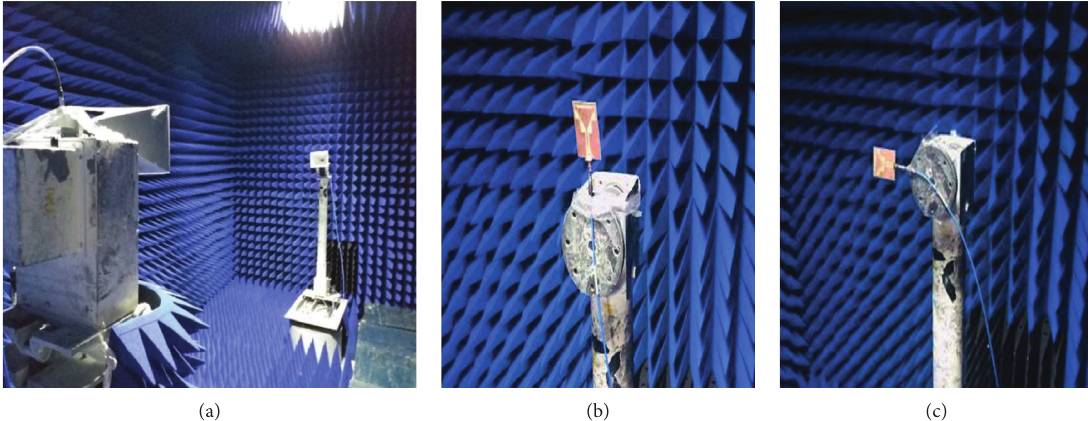
Figure 6: Photograph of tested antenna inside the chamber room. (a) The placement of identical horn antennas. (b, c) Fabricated prototype (AUT) placement on the azimuth